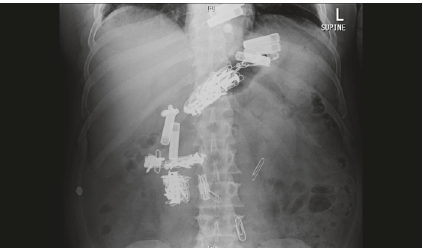
Figure 1: Abdominal X-ray showing multiple ingested substances lateridentified as 50 paperclips, 50 screws, eight batteries, and seven razor blades covered in